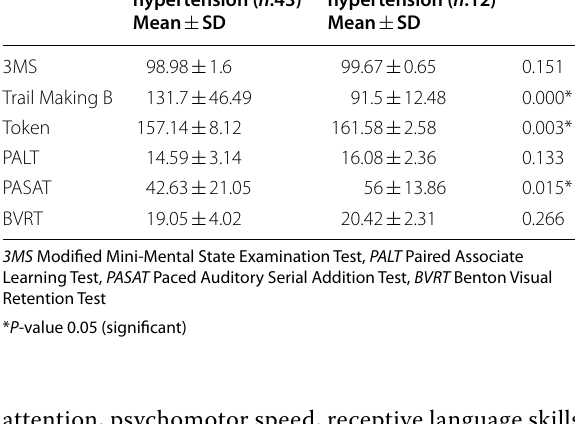
3MS Modified Mini-Mental State Examination Test, PALT Paired Associate Learning Test, PASAT Paced Auditory Serial Addition Test, BVRT Benton Visual